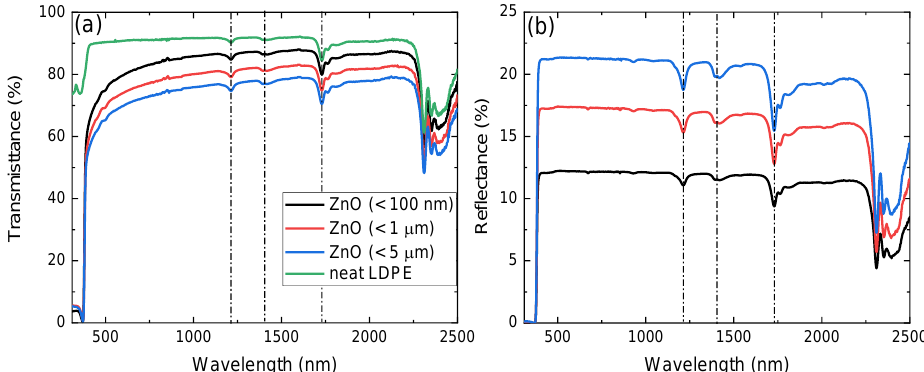
Figure 3. ( a ) Transmittance of neat LDPE (green) and ZnO of free-standing particle size of < 100 nm (black), < 1 µ m (red), and < 5 µ m (blue) embedded in LDPE from 310 nm to 2500 nm. ( b ) Reflectance of the latter with the exception of neat LDPE, omitted for clarity. The dash-dot lines in the spectra denote the absorption peaks of LDPE.